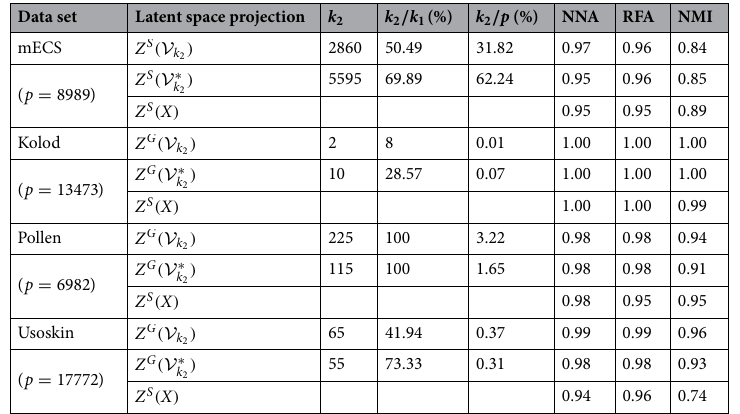
) and Z S ( X ) for the four data sets. 2